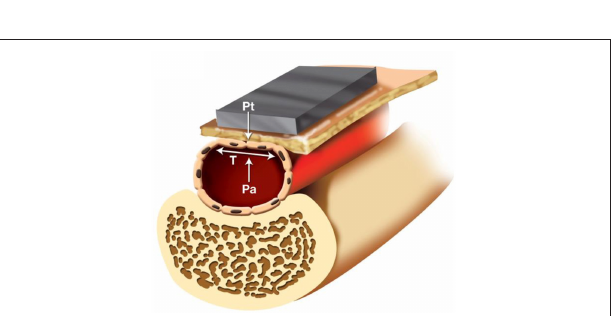
FIGURE 2 | Arterial tonometry based cuff-less blood pressure measurement. First, a non-invasive arterial tonometer is placed on the skin overlying a peripheral artery. Then, the sensor applies force to compress the artery against the underlying bone until the maximum pulse pressure is achieved. At that point, it can be assumed that the only force acting on the artery is the inward force of the tonometry sensor (P t ), the outward force of the intravascular blood pressure (P a ), and the wall tension of the underlying artery (T). The maximum pulse pressure occurs when the artery is compressed such that the wall tension force is directed perpendicularly to the tonometry sensor and blood pressure forces. Directing the wall tension perpendicularly ensures that the tonometric force measured by the sensor only represents the blood pressure of the underlying vessel, and any deviation from this axis may introduce tangential forces and measurement